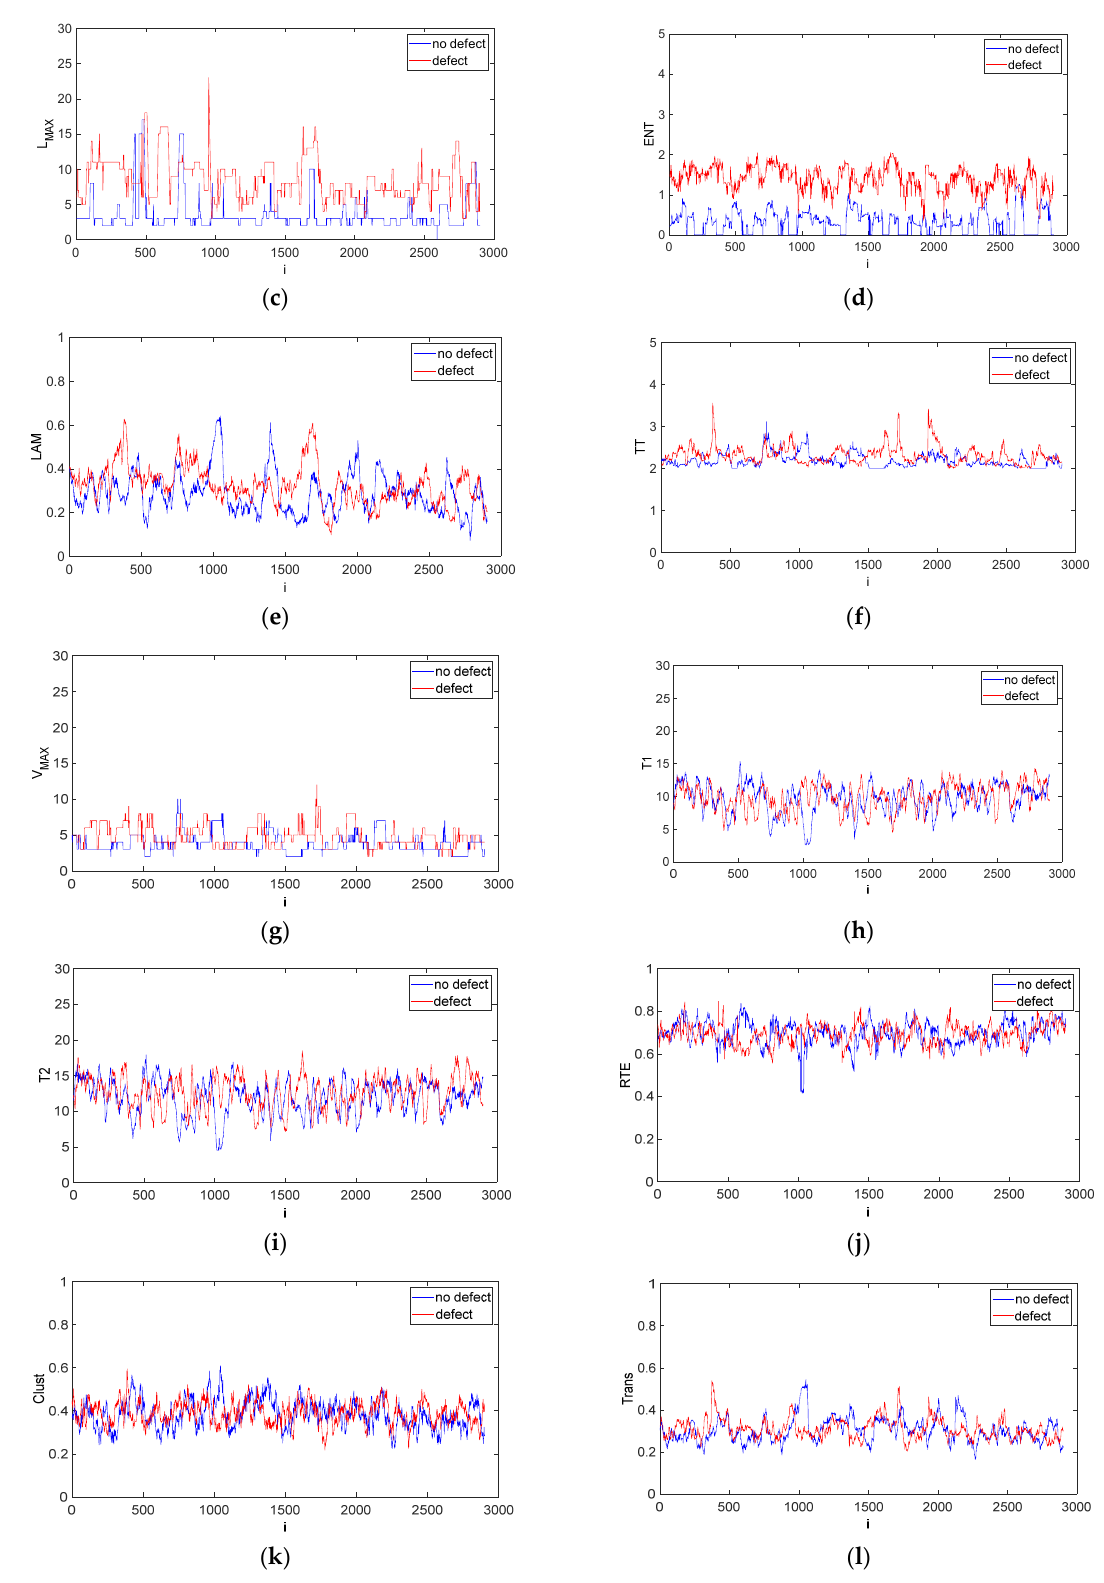
Figure 10. Recurrence quantification time evolution obtained by moving window technique for GFRP without defect (blue line) and with defect (red line): DET ( a ), L ( b ), L MAX ( c ), ENT ( d ), LAM ( e ), TT ( f ), V MAX ( g ), T1 ( h ), T2 ( i ), RTE ( j ), CC ( k ) and TRANS ( l ). The calculations were made with w s = 100 and w i = 1. The quantifications show system behaviour over